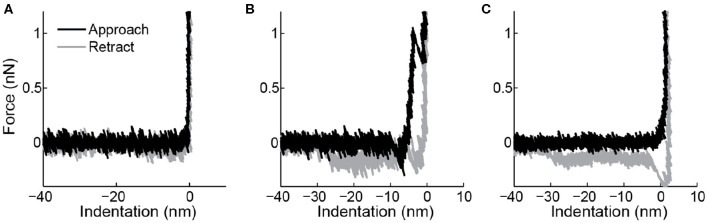
Force indentation curves taken on the surface. (A) Overlap between trace (black) and retrace (gray) and a sharp transition when the tip touches the surface suggest this is a clean tip. (B) A breakthrough event in the trace and a force plateau in the retrace indicating a lipid bilayer tether show that this tip was contaminated with a lipid bilayer. (C) This tip shows a non-abrupt change in slope when it hits the surface and again a force plateau in the retrace, indicating contamination with a lipid bilayer.